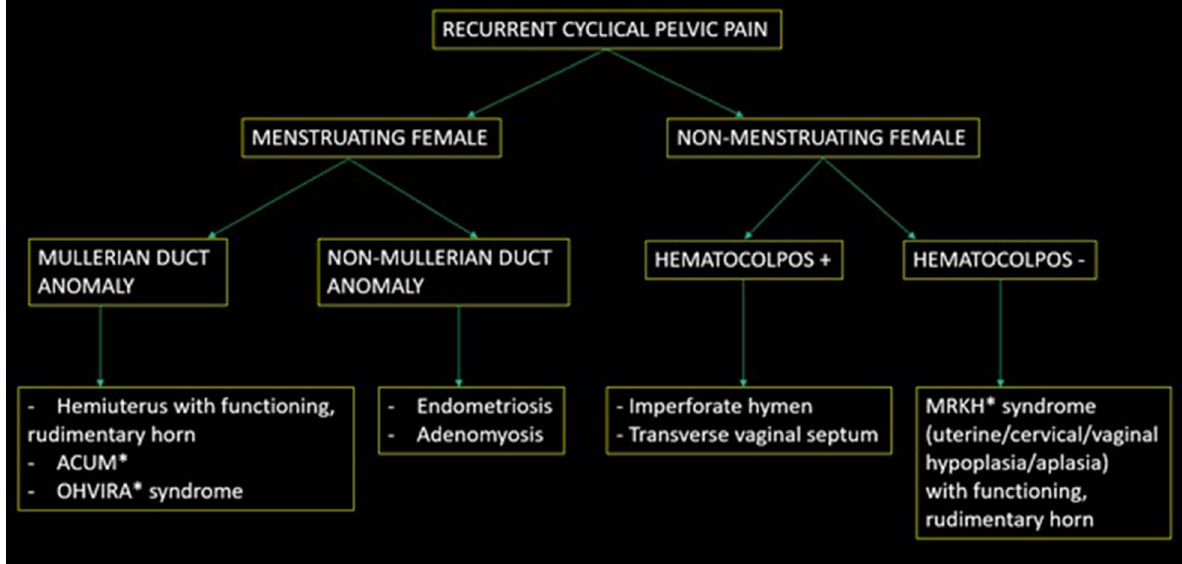
Fig. 5 Schematic approach to young women with recurrent cyclic pelvic pain. MRKH*-Mayer-Rokitansky-Küster-Hauser syndrome, ACUM*-Accessory and cavitated uterine mass (ACUM), OHVIRA*-Obstructed hemivagina with ipsilateral renal